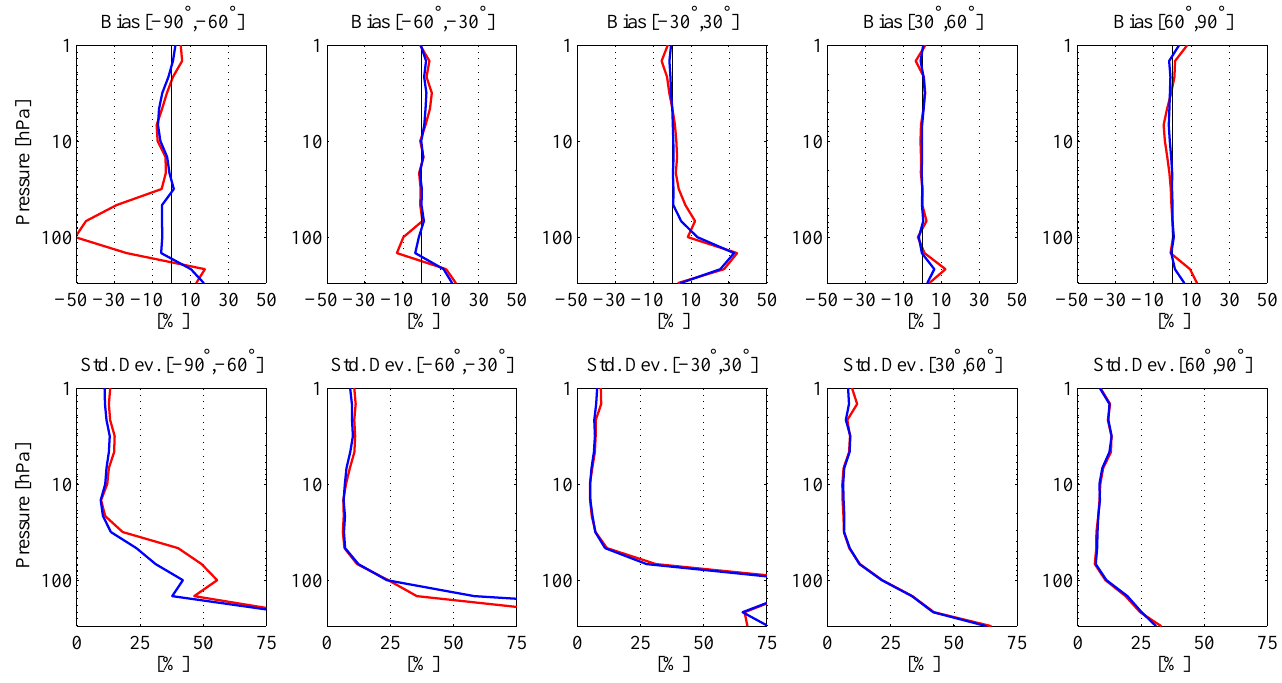
Fig. 3. Bias (top row) and standard deviation (bottom row) of the Observations-minus-Forecast (OmF) statistics between the analyses and the MIPAS data, in percent. Statistics are done at five latitude bands denoted in the title of each plot. Blue and red lines represent the statistics obtained, repectively, by the CORREL and DIAG runs.